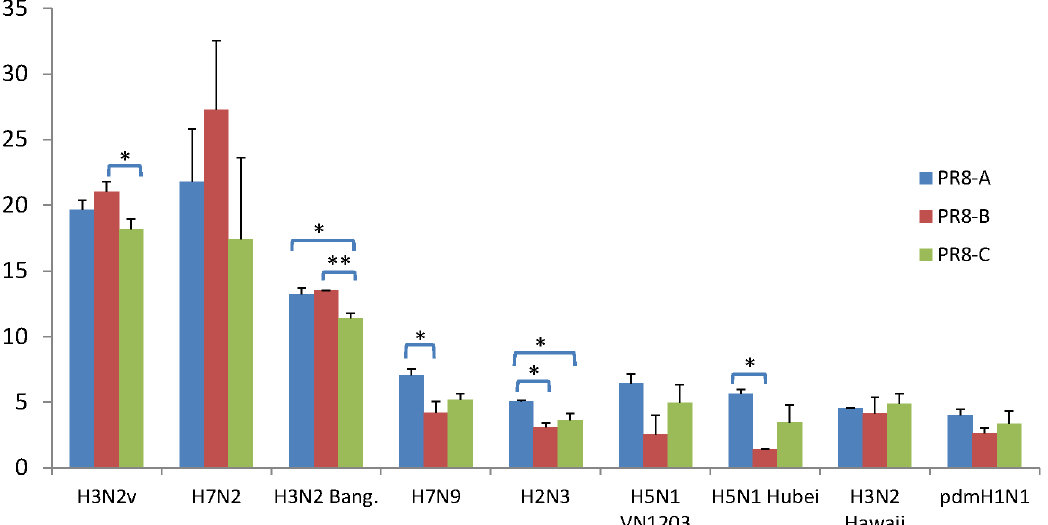
Fig 2. Total viral protein yields in virions concentrated from allantoic fluid. Reassortant viruses were propagated in embryonated eggs and purified from allantoic fluid by sucrose density gradient ultracentrifugation. Each virus was propagated and purified at least twice independently using a different batch of eggs. Total viral protein in purified virus samples was determined by BCA as described in Materials and Methods. Statistical significance: * , P < 0.05; ** , P < 0.01.